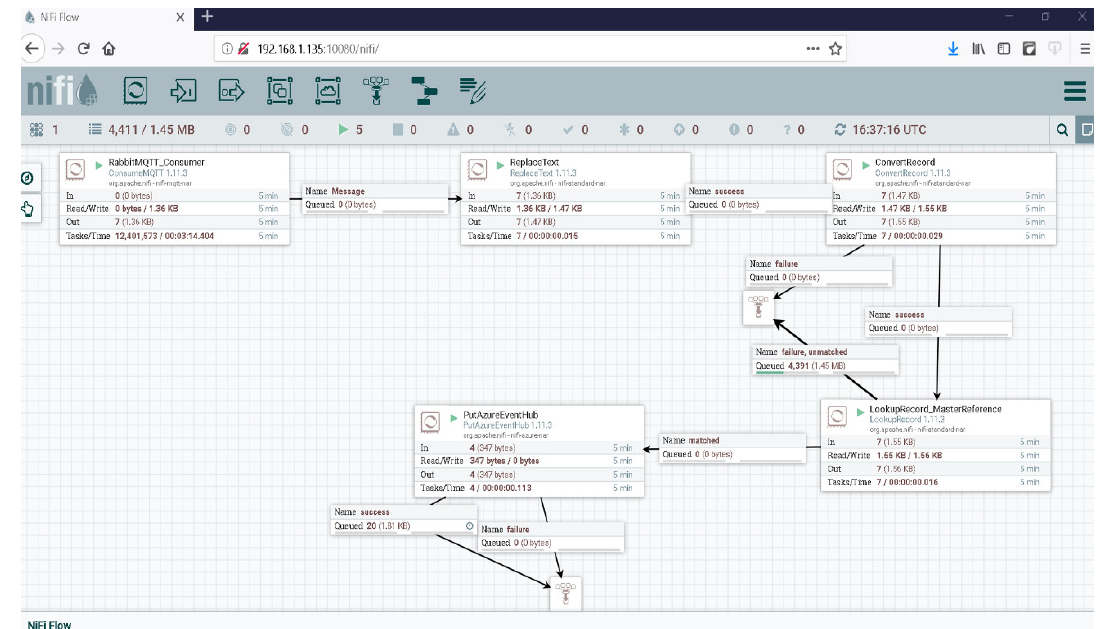
Figure 8. Apache NiFi data flow design.